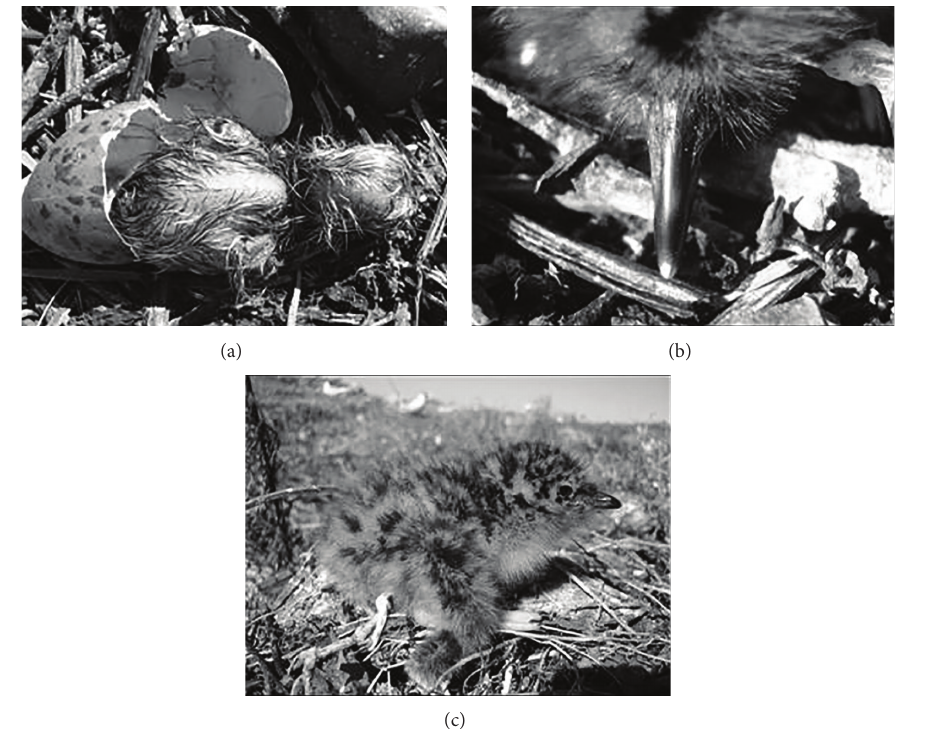
Figure 3: Beginning of the JI phase of Sterna hirundinacea (a), egg tooth detail (b), and color of the plumage and end of the stage (c).